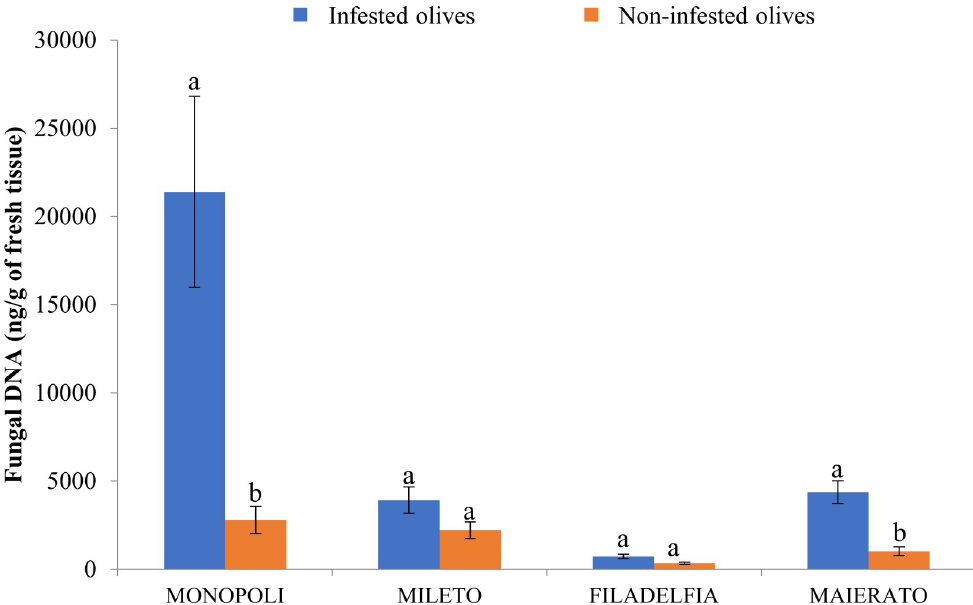
Fig 4. Comparison of total fungal DNA in infested and non-infested olive drupes in the four investigated localities (Monopoli, Mileto, Filadelfia and Maierato). Independent statistical analyses were performed for each locality. Different letters indicate significantly different values according to ANOVA univariate analysis of variance (P � 0.05). Bars indicate standard errors of the